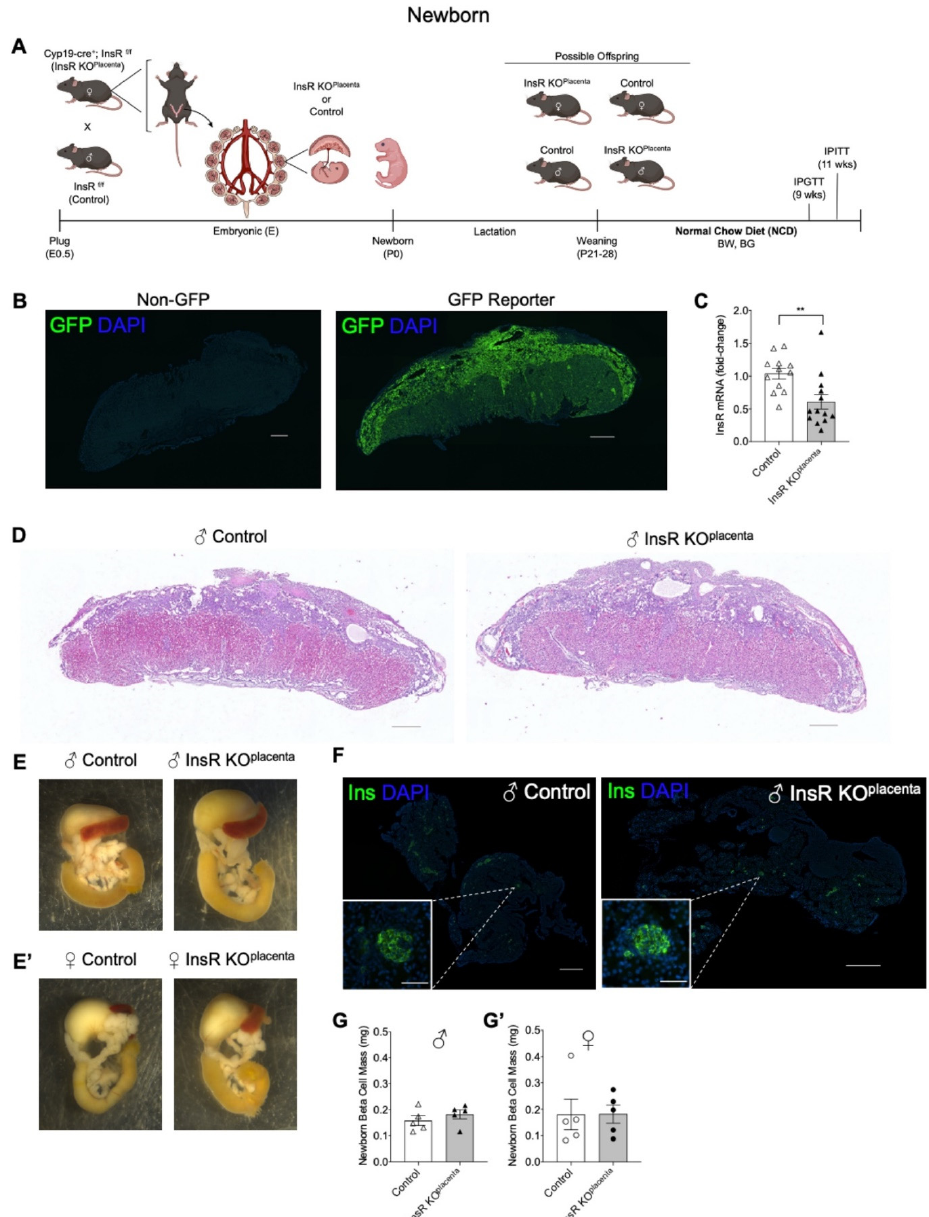
Figure 1. Newborn offspring with placenta-specific InsR ablation presented with normal body weight and pancreatic β -cell mass. ( A ) Experimental schematic for generating InsR KO placenta and littermate controls. ( B ) GFP reporter (Cyp19-cre; CAG +/+ ) expressing endogenous green fluorescence (GFP) in a mouse embryonic E17.5 placenta section compared to the non-GFP control (CAG +/+ ) (scale bars: 500 µ m). ( C ) InsR mRNA expression in the E17.5 InsR KO placenta compared to controls by quantitative reverse transcription polymerase chain reaction (qPCR) ( n = 12, 13). ( D ) Histology of the E17.5 male control placentas (left) compared to InsR KO placenta (right) (scale bars: 500 µ m). Background of images was subtracted post-imaging. ( E ) Gross morphology of the male and ( E’ ) female control (left) and the InsR KO placenta (right) newborn pancreata. ( F ) Whole pancreatic sections (scale bars: 500 µ m) of the male newborn control (left) and the InsR KO placenta (right) mice immunostained for insulin-positive islets (green) and DAPI (blue). Single islet β -cells (scale bars: 50 µ m) shown as insets. Single islet images were cropped post-imaging to highlight the single islet. ( G ) Beta cell mass for the male ( n = 5) and ( G’ ) female ( n = 5) newborns. The values are reported as the means ± SEM, ** p <0.01. E: embryonic; P: postnatal; BW: body weight; BG: blood glucose; IPGTT: intraperitoneal glucose tolerance test; IPITT; intraperitoneal insulin tolerance test; NCD: normal chow